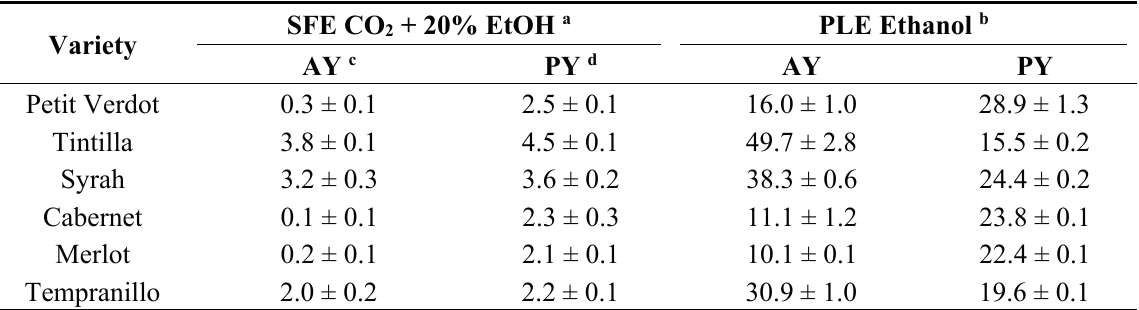
Figure 1. Extraction yield and antioxidant activity obtained by supercritical fluid extraction (SFE) with CO 2 + 20% ethanol as co-solvent (100 bar, 55 °C, 20 g/min CO 2 , 5 g/min ethanol, 3 h) from different grape pomace varieties. Table 1. Extraction yields of anthocyanins and phenolic compounds expressed as mg/g dry grape